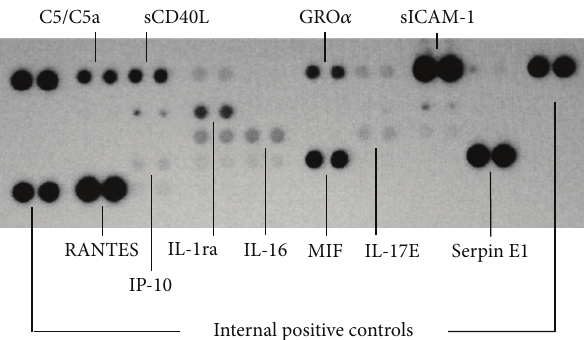
Figure1:Representativeimmunoblottingforsemiquantitativeanal- ysis of proteins investigated in the study. C5/C5a: complement component 5/5a; sCD40L: soluble CD40 ligand; GRO 𝛼 : growth- regulated oncogene alpha; IL-16: interleukin 16; IL-1ra: interleukin- 1 receptor antagonist; IL-17E: interleukin 17E; IP-10: interferon gamma-induced protein-10; MIF: macrophage migration inhibitory factor; RANTES: regulated on activation, normal T cell expressed and secreted; sICAM-1: soluble intercellular adhesion